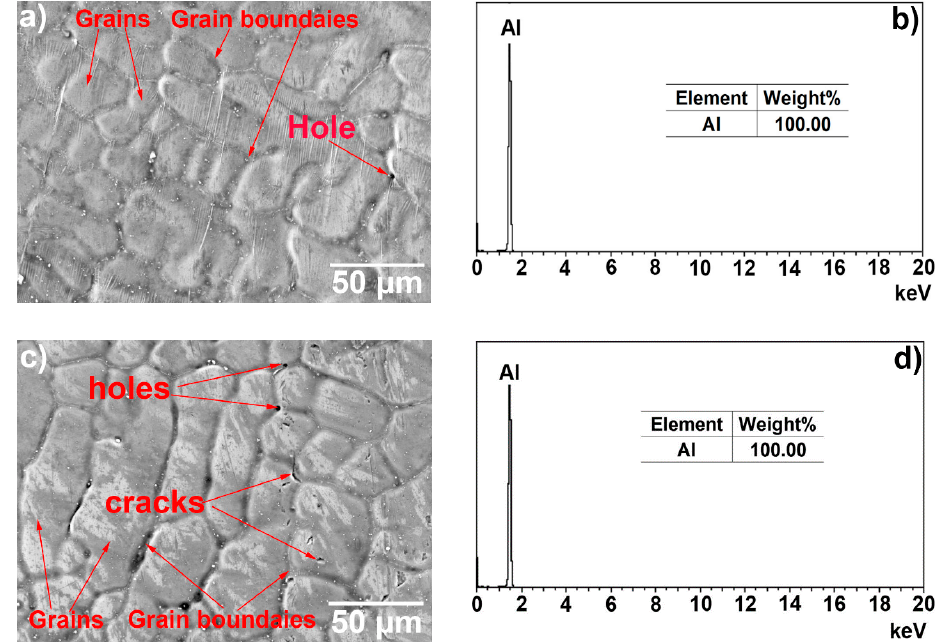
Figure 1. Surface morphologies and energy X-ray dispersive spectrometry (EDS) spectra and elemental compositions of hot-dip aluminised coatings on TA2 substrates: ( a , b ) T-1 and ( c , d ) T-2 samples,